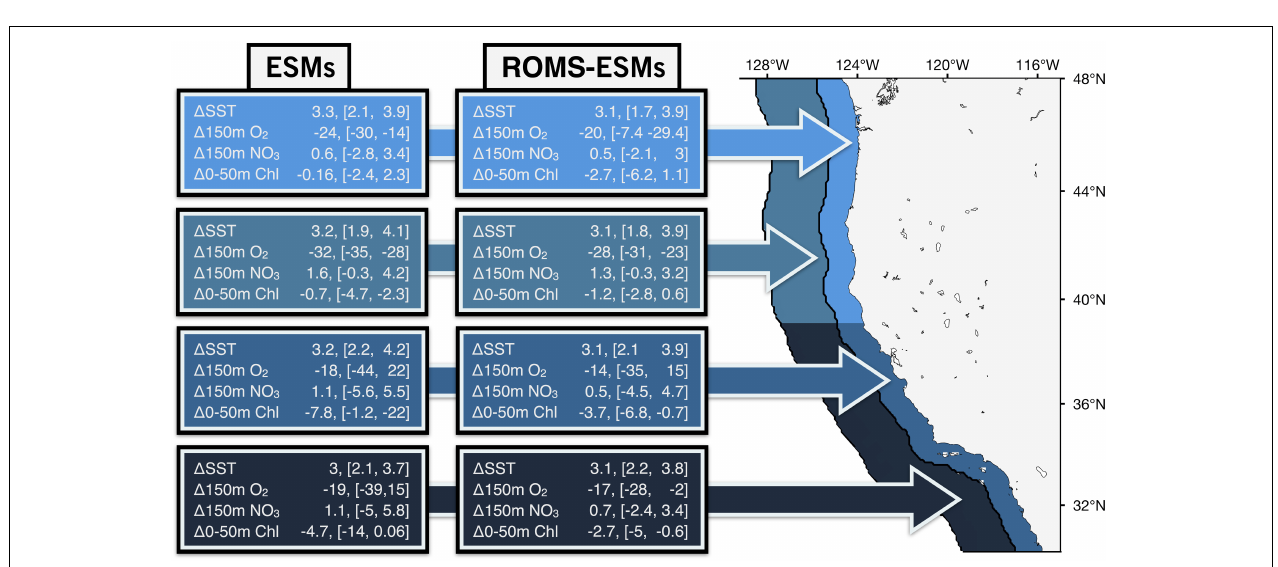
FIGURE 10 | Schematic table summarizing the main physical and biogeochemical variables future changes for the period (2070–2100), from the ESMs (left) and ROMS-ESMs (right) projections for the nearshore (from a distance of 100 km to the coast) and offshore (from 100 to 300 km) for the northern and southern CCS coast. The variables listed are: SST ( ◦ C), NO 3 and O 2 at 150 (mmol/m 3 ) and 0–50 m vertically integrated chlorophyll (mg/m 2 ). For each variable, the mean change and inter-model range change during the period are shown.